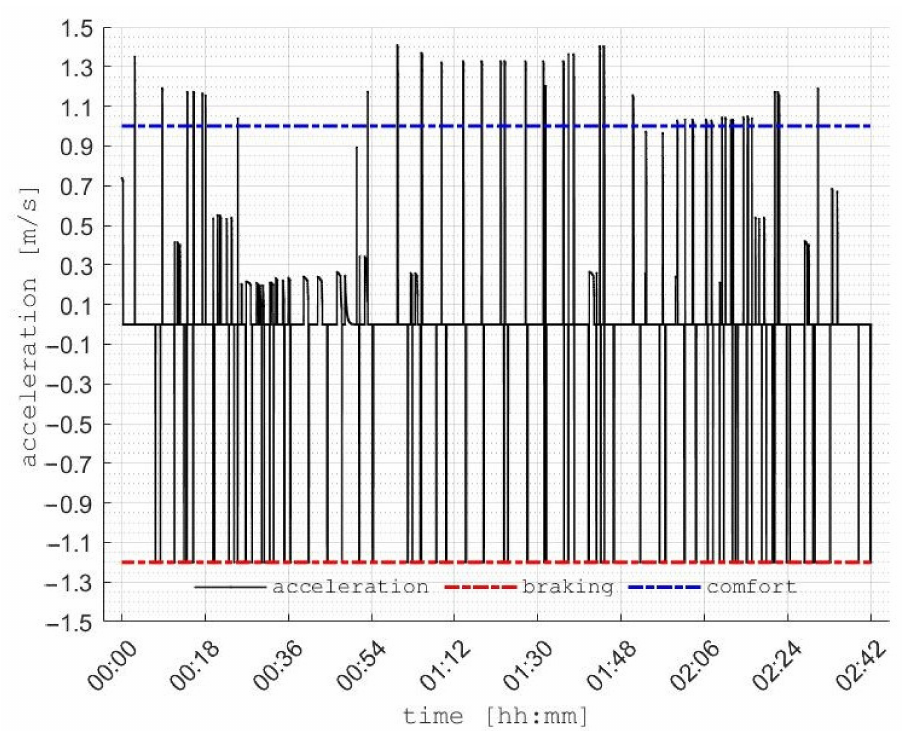
Figure 8. Acceleration